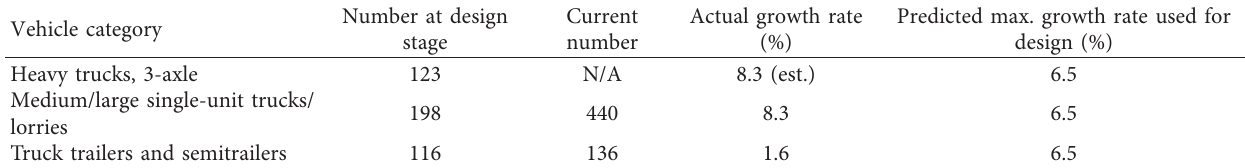
Table 1: Comparison of the design and actual growth rates.